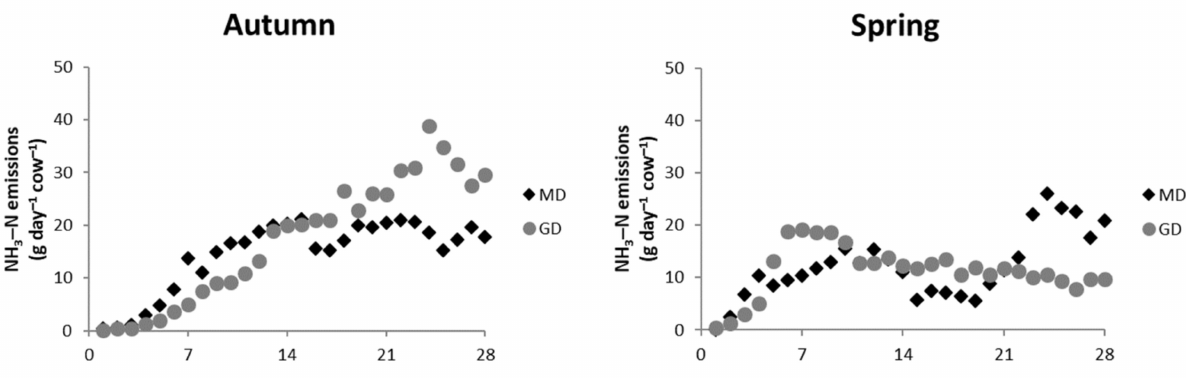
Figure 5. Dynamics of ammonia (NH 3 –N) emissions (g cow –1 day –1 ) over the 28 d of litter accumula- tion in the barn in the autumn and spring as a function of diet (a maize-silage-based diet (MD) or a grass-based diet